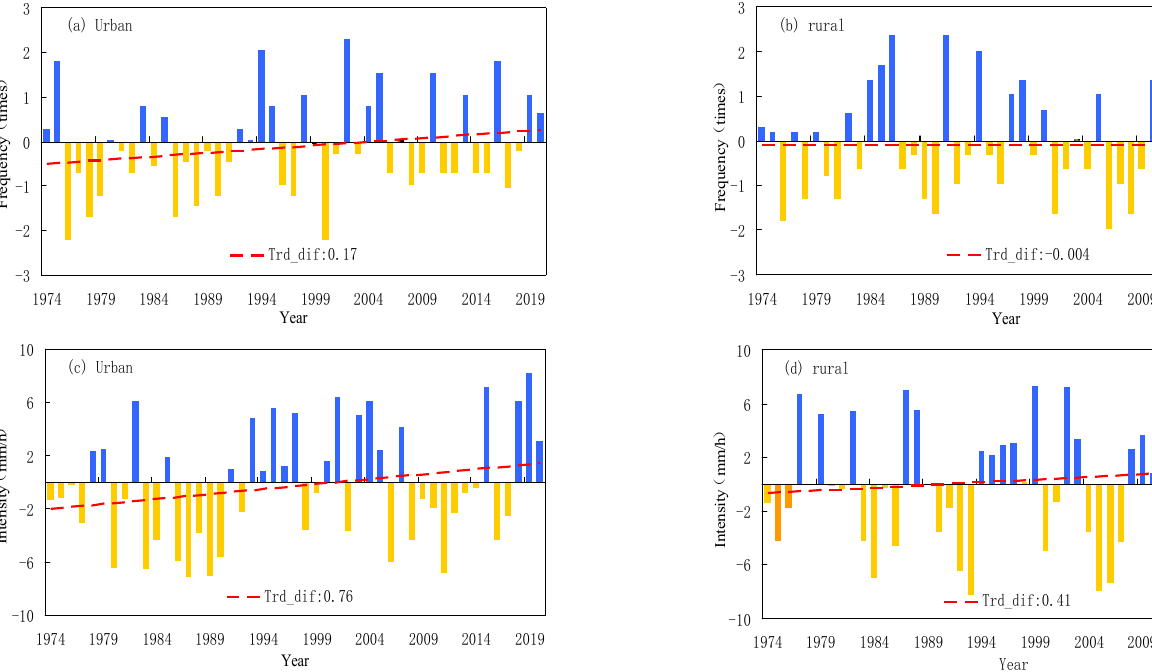
Figure 7. Interannual variations of regional-averaged ExHP ( a , b ) frequency and ( c , d ) intensity at urban and rural stations in Shenyang from 1974 to 2020. Table 3. Urbanization impact and its contribution rate (%) on annual extreme hourly precipitation frequency and intensity at urban and rural stations in Liaoning Province from 1974 to 2020.